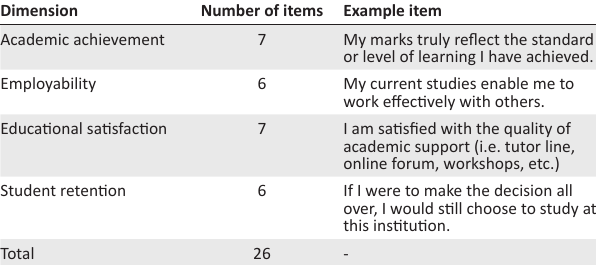
TABLE 2: Initial structure of the